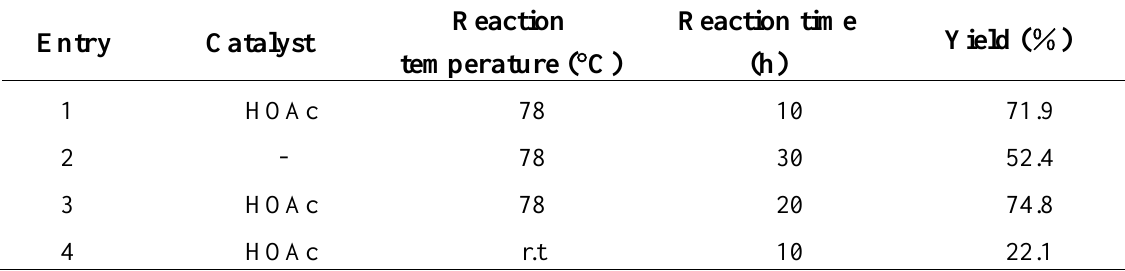
Table 2. The effect of reaction conditions on yield of title compound